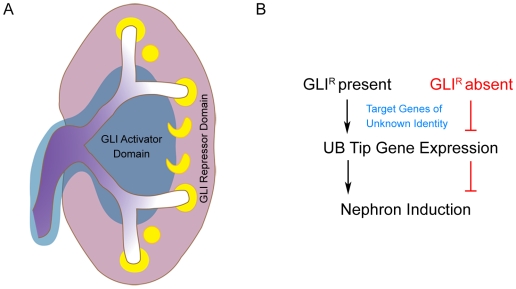
Model for HH signaling function in the ureteric epithelium.(A) During normal renal morphogenesis, Shh secreted from the medullary collecting ducts (purple) establishes a gradient of HH signaling resulting in distinct medullary GLI activator (blue) and cortical GLI repressor domains. While HH signaling activity has no functional requirement in the ureteric cell lineage, the absence of HH signal, and thereby function of GLI3 repressor is critical for ureteric tip cell-specific gene expression and subsequent nephron induction (B). In the absence of cortical GLI repressor, such as in Ptc1−/−UB mice, ureteric tip cell-specific gene expression is impaired resulting in reduced nephrogenesis and renal hypoplasia.